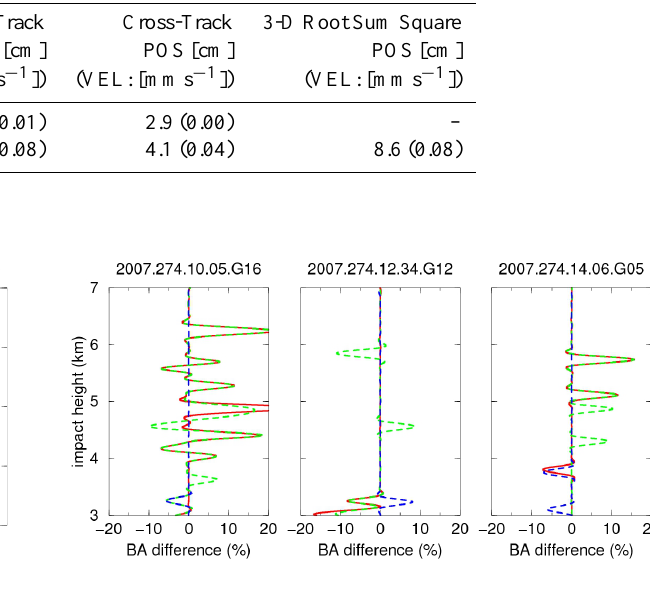
Fig. 8. Differences of the bending angles from those retrieved from 50Hz down-sampled signals (as discussed in Sect. 3.4) for three tropical occultations. Red, green and blue lines corresponds to down-sampling to 100Hz, the use of raw 1000Hz samples and down-sampling to 50Hz with Gaussian filter, respectively.